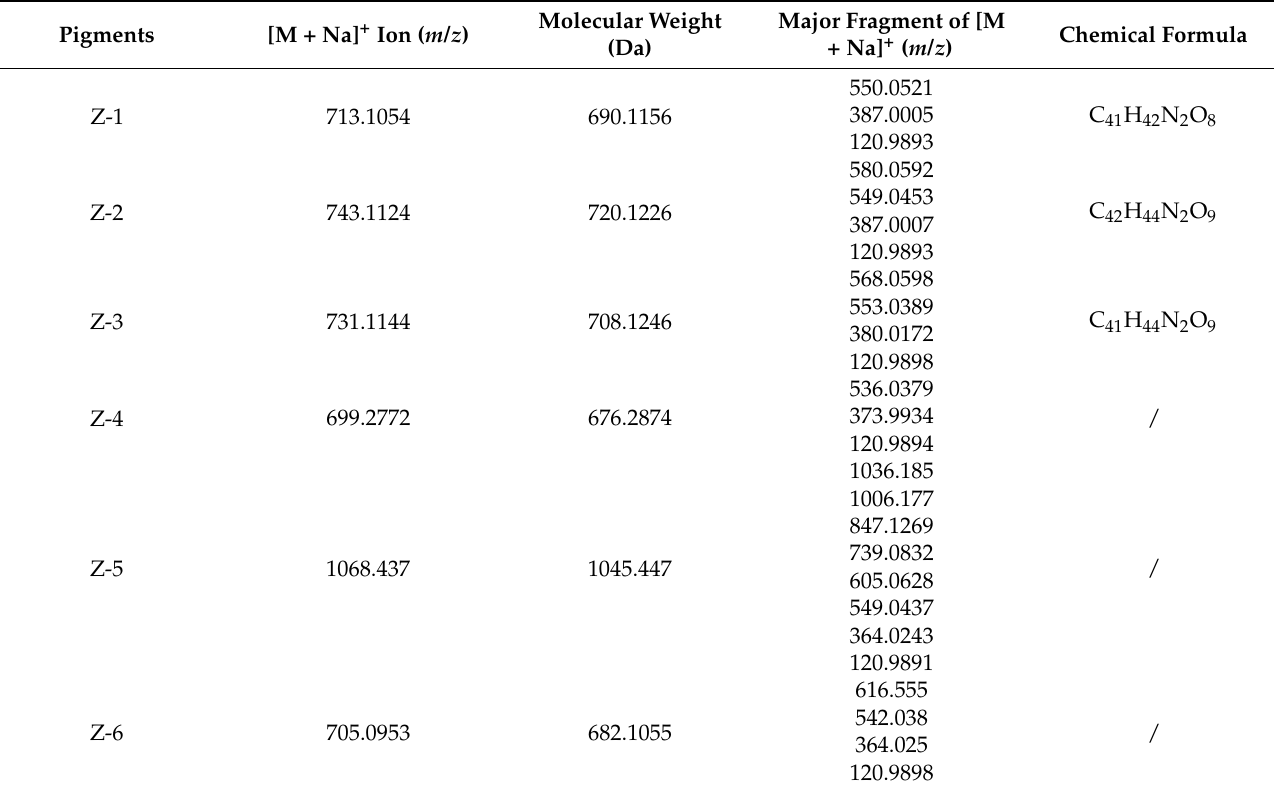
Table 6. Accurate mass measurements and elemental compositions of the Na + adduct ions and main product ions by